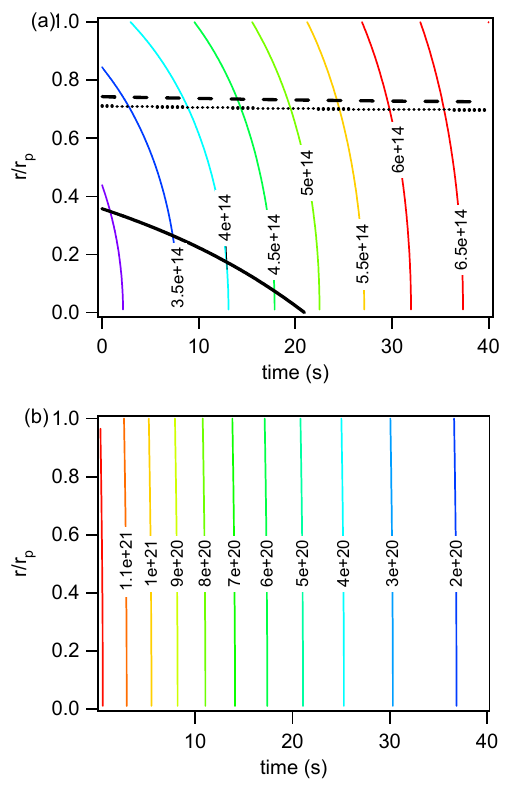
Fig. 6. Temporal evolution of bulk concentration profiles for model 31 base case 1 for (a) ozone and (b) oleic acid (KM-SUB with n = 100). The y-axis indicates the radial distance from the particle cen- ter ( r) normalized by the particle radius, ranging from the particle core ( r/r p = δ/r p ≈ 0 ) to the near-surface bulk ( r/r p = 1). The col- ored lines are isopleths of bulk concentration with labeled in units of cm − 3 (blue=low, red=high). The black solid line represents the reacto-diffusive length for ozone normalized by the particle radius (1 − l rd , X /r p ) . The black dotted line represents the 50% isoline for the concentration difference between the particle core and the near- surface bulk, and the black dashed line shows 63% isoline of L ∗